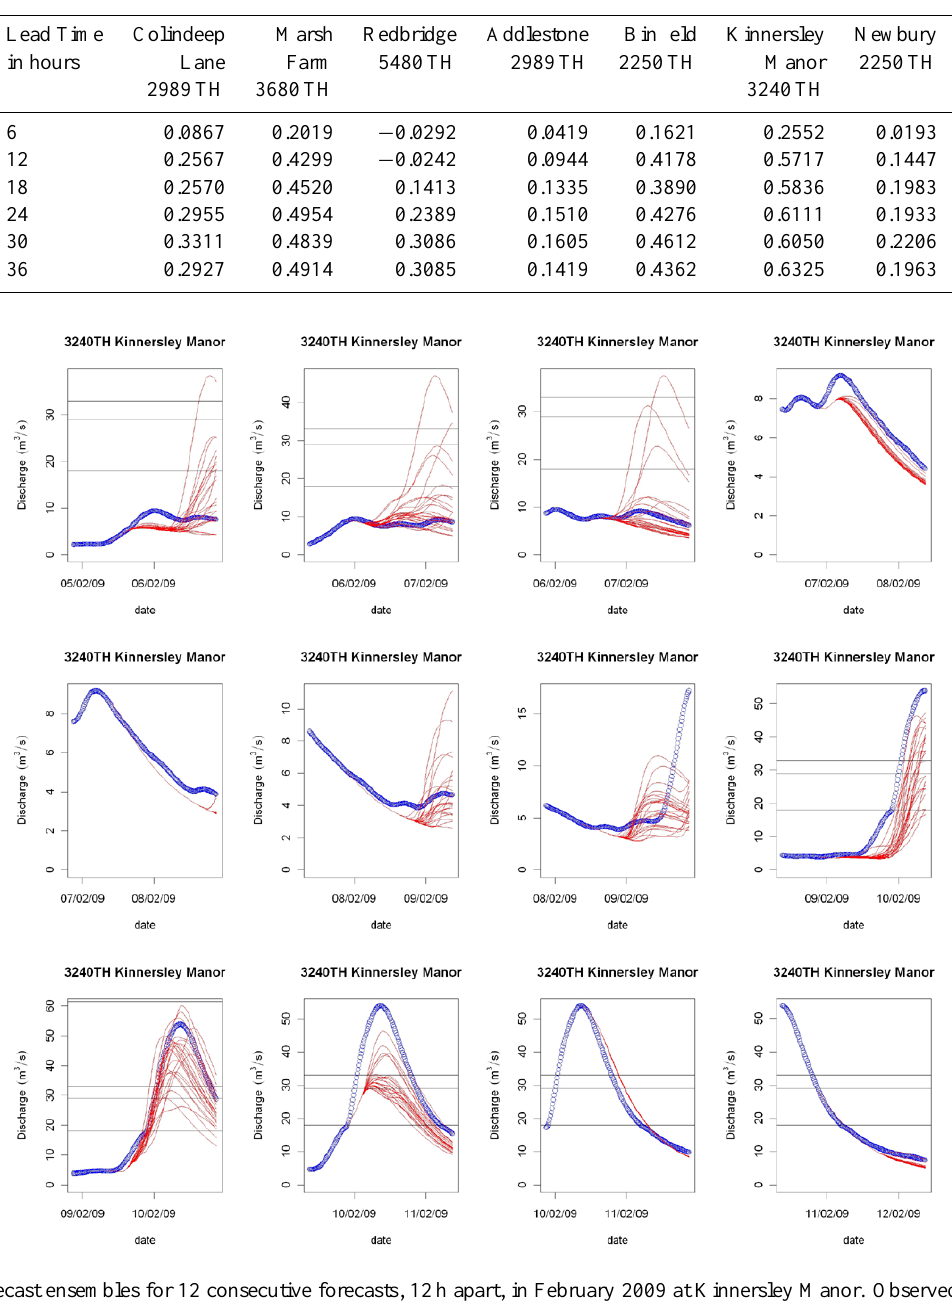
Table 4. CRPS for the period July 2008 to February 2009 using the na¨ıve forecast (persistence) as reference forecast.